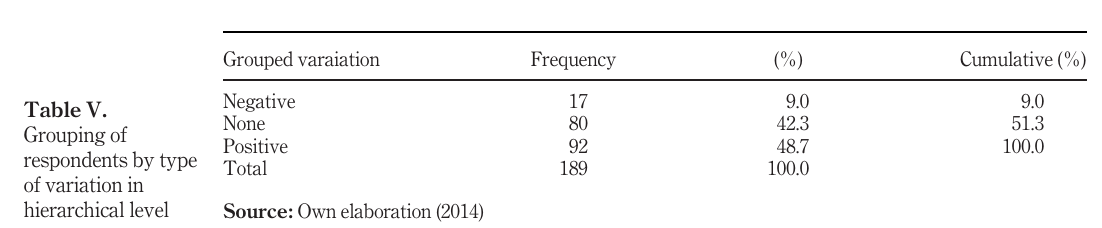
Table IV. Frequency of hierarquical levels during the program and currently